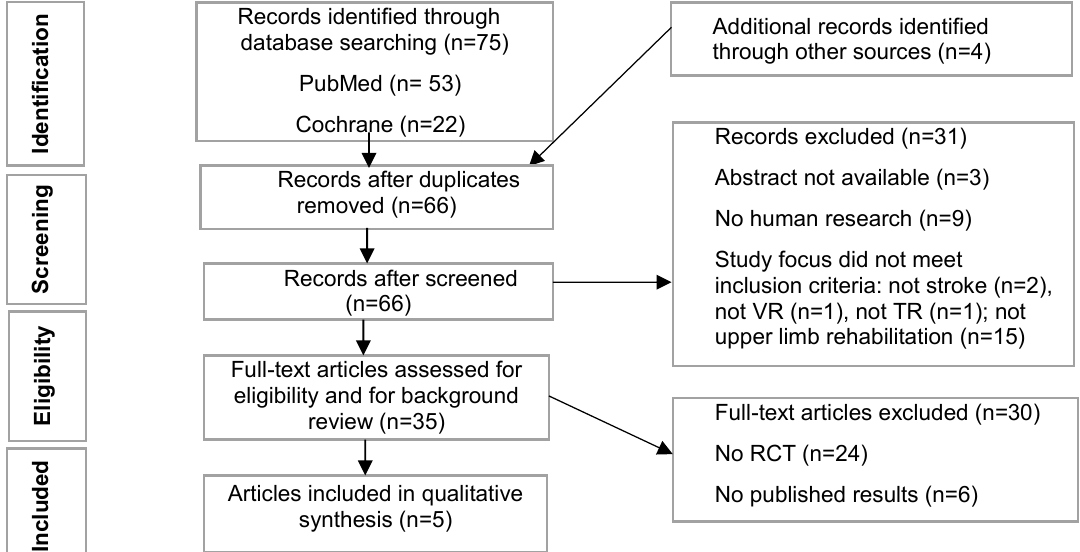
Flow Diagram Adapted from Preferred Reporting Items for Systematic Reviews and Meta-Analysis (PRISMA)